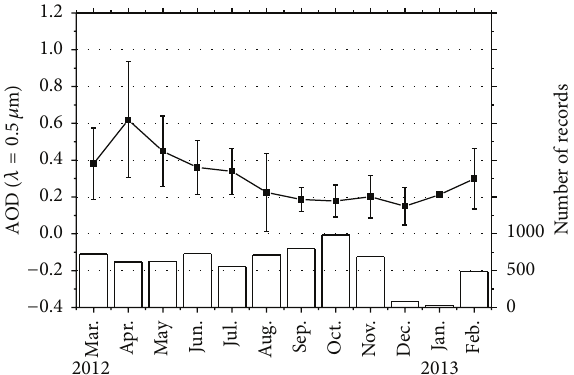
Figure 3: The monthly variation of AOD. The left axis correspond- ing to AOD and the right axis corresponding to number of